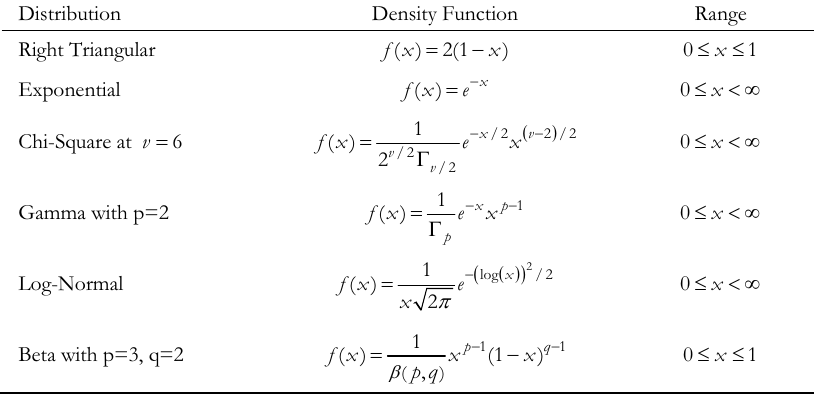
Distributions used for generating the selection probabilities